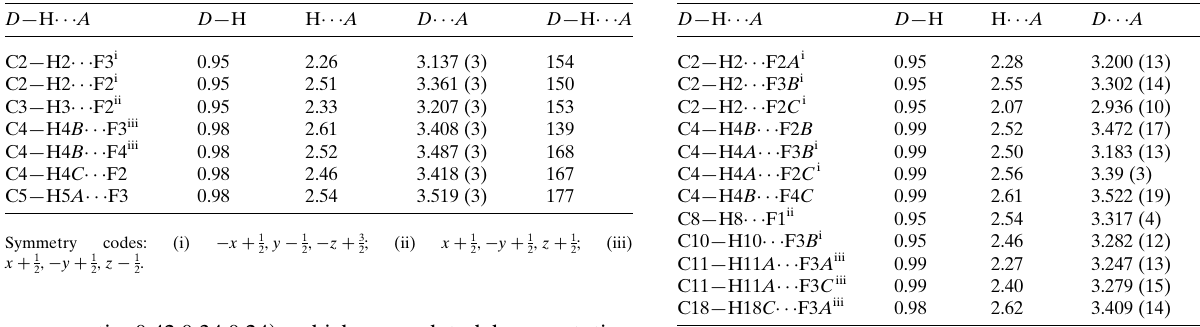
Table 2 Hydrogen-bond geometry (A˚ , (cid:4) ) for 2 .